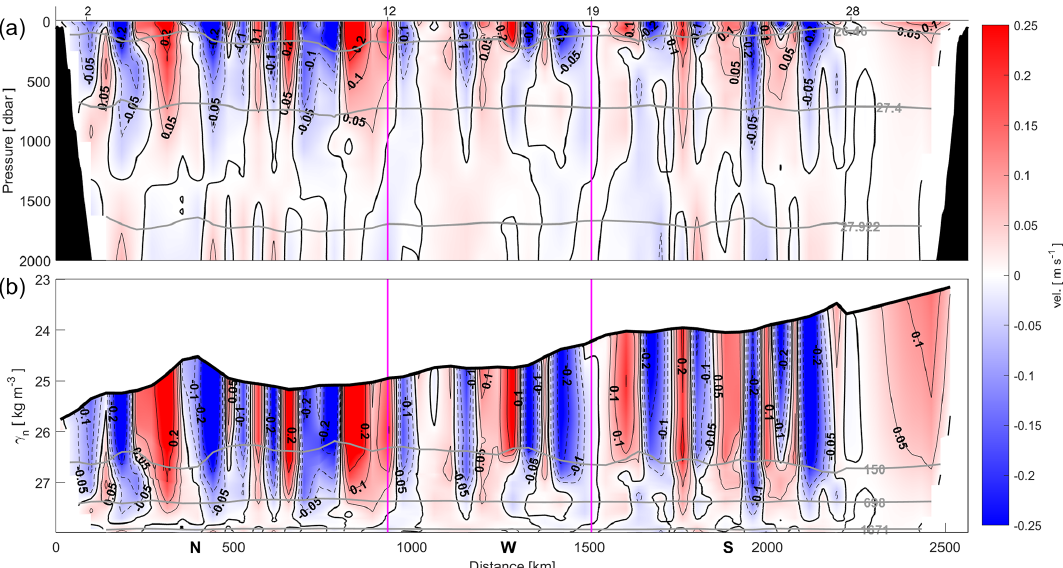
Figure 13. Sections of the absolute geostrophic velocity perpendicular to each transect with respect to depth (a) and γ n (b) during the FLUXES-I cruise (including WOA stations). The velocity sign was selected on geographic criteria (positive sign northward and eastward). The direction chosen for the representation is the same as in Fig. 3. The zero contour line is the thick black line. The northwestern and southwestern corners are indicated by vertical pink lines at stations 12 and 19. In depth sections, the isoneutrals that delimit the surface, central, intermediate and deep water are represented by gray contours. In γ n sections, the depths of 150, 698 and 1671m are also shown.